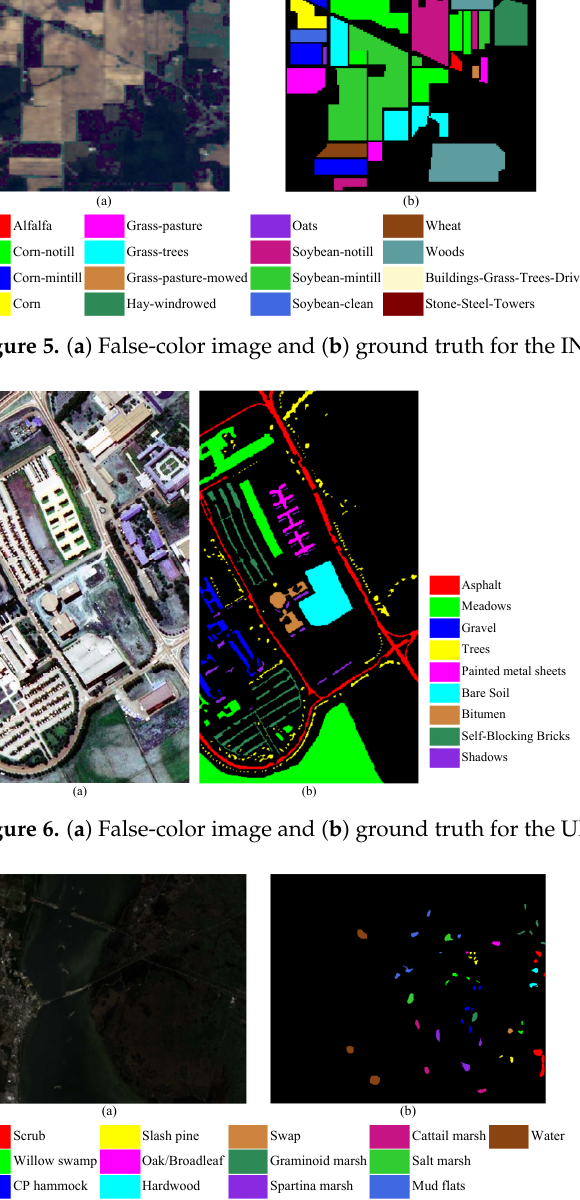
Figure 7. ( a ) False-color image and ( b ) ground truth for the KSC data